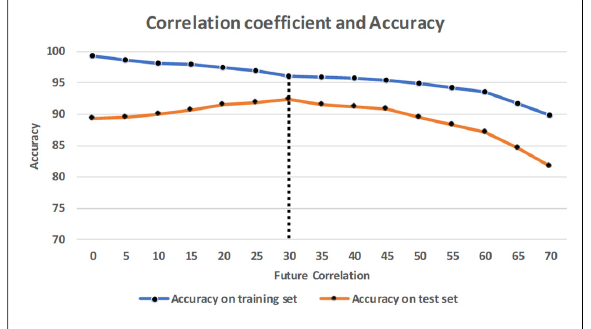
Figure 3. Correlation coefficient vs . accuracy.